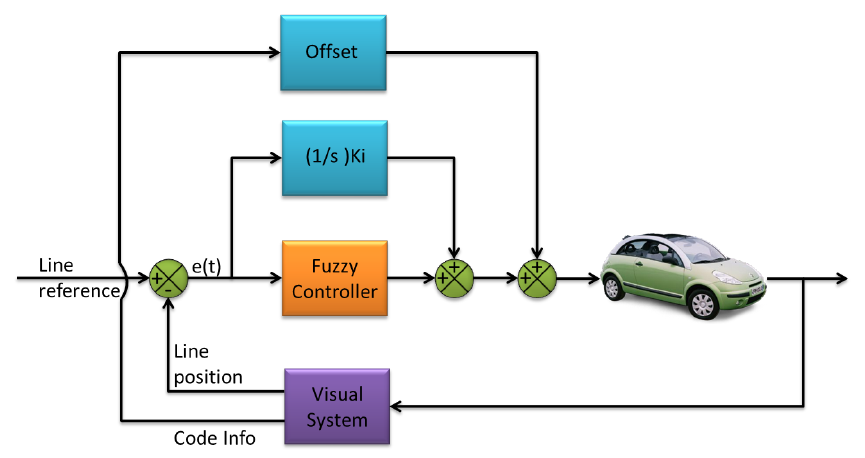
Figure 6. Simplified control loop of the visual control